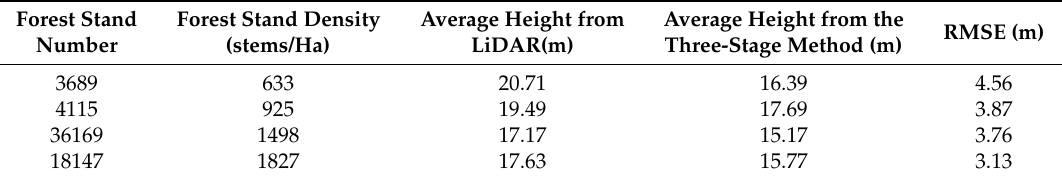
Table 2. Assessment of forest stand height inversion errors from the three-stage inversion method.